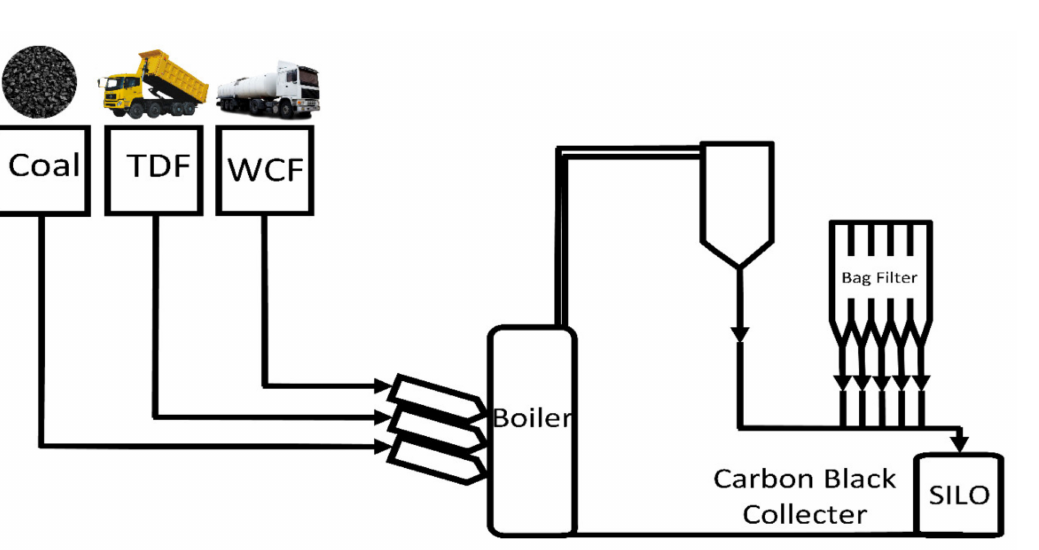
Figure 5. Tire-derived fuel